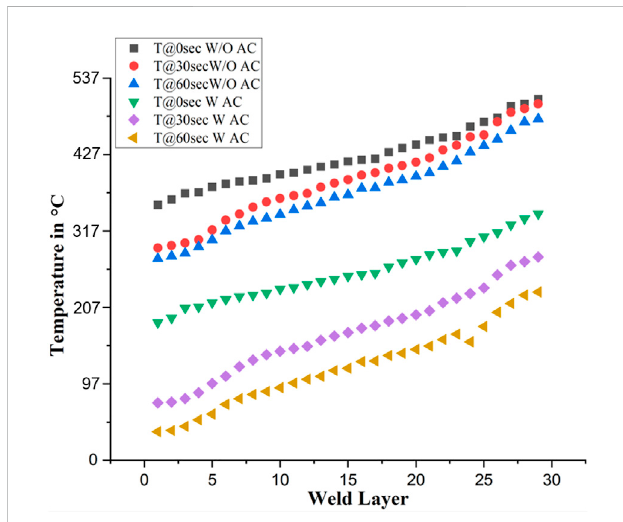
FIGURE 6 Temperature readings at 0, 30, and 60s of each deposited layer for the cylinder with and without active cooling.